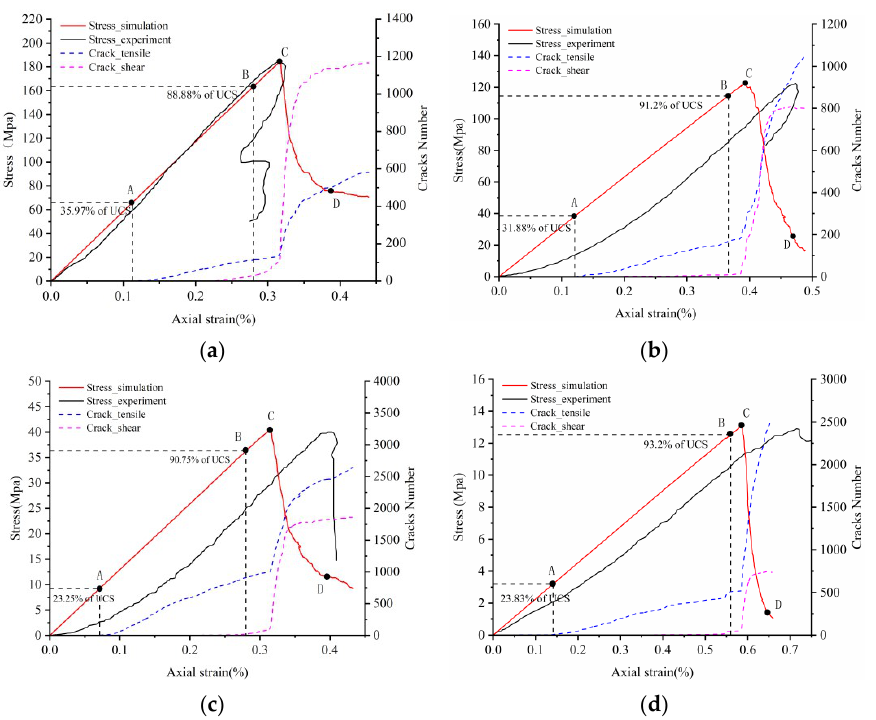
Figure 5. Comparing the experimental and simulated stress–strain and crack–strain curves for various rock specimens: ( a ) LdB granite, ( b ) Augig granite, ( c ) TS, and ( d ) coal. Note: Initial crack threshold (Point A), crack damage threshold (Point B), peak failure (Point C) and post-peak residual (Point